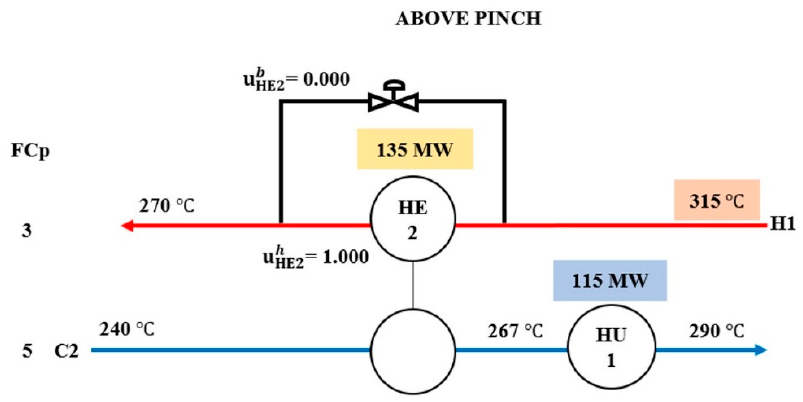
Figure 11. HEN design with increasing T S for the hot stream H1 above the pinch.